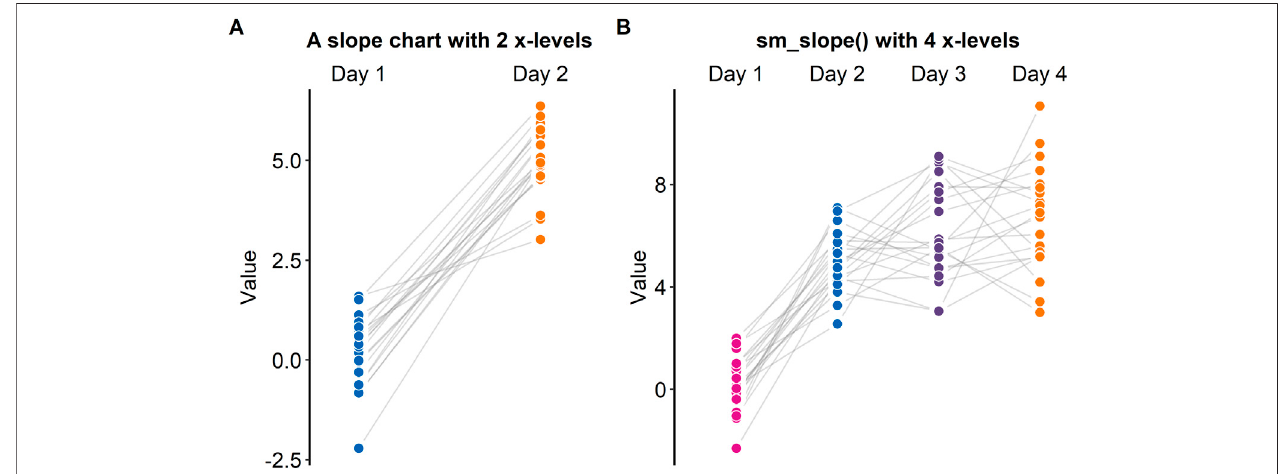
FIGURE 5 | Slope charts drawn with “ sm_slope () ” , which is a function of smplot . (A) A slope chart with two discrete x-levels. (B) A slope chart with four discrete x-levels.